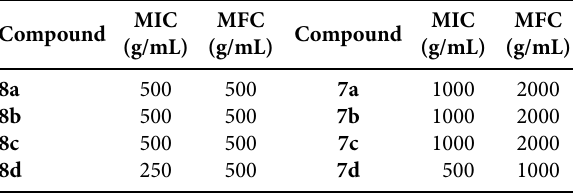
Table 2 . In vitro antifungal activity of synthetic compounds against A. fumigatus. MIC MFC MIC Compound Compound